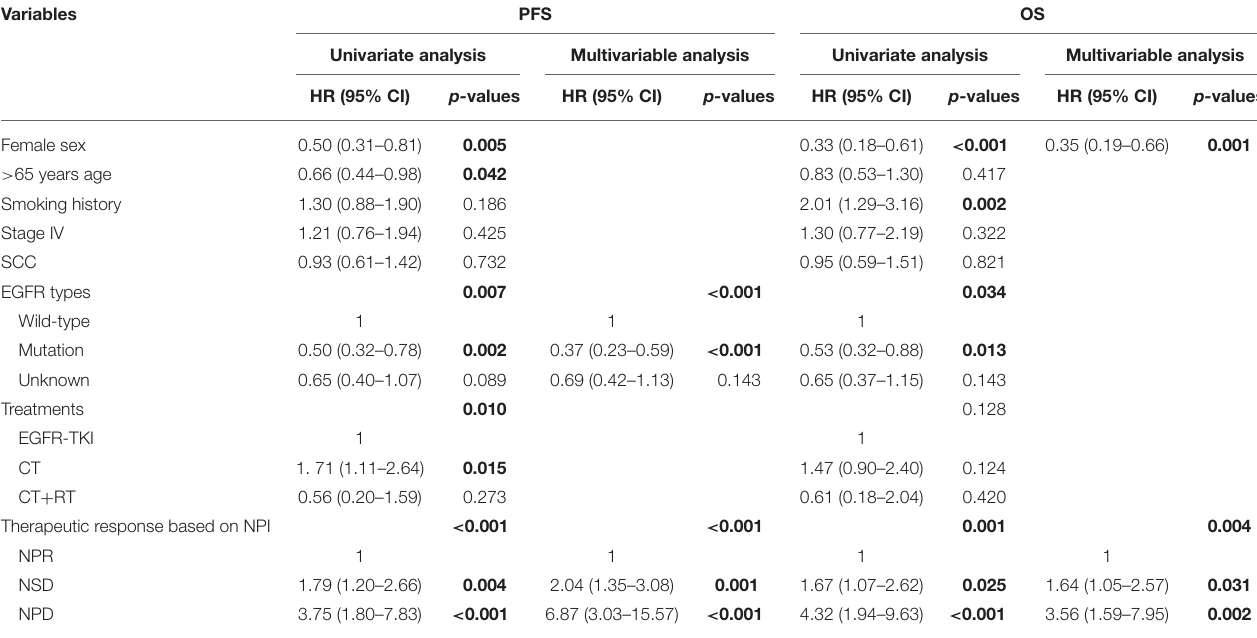
TABLE 4 | Cox regression based on NPI in total cohort.